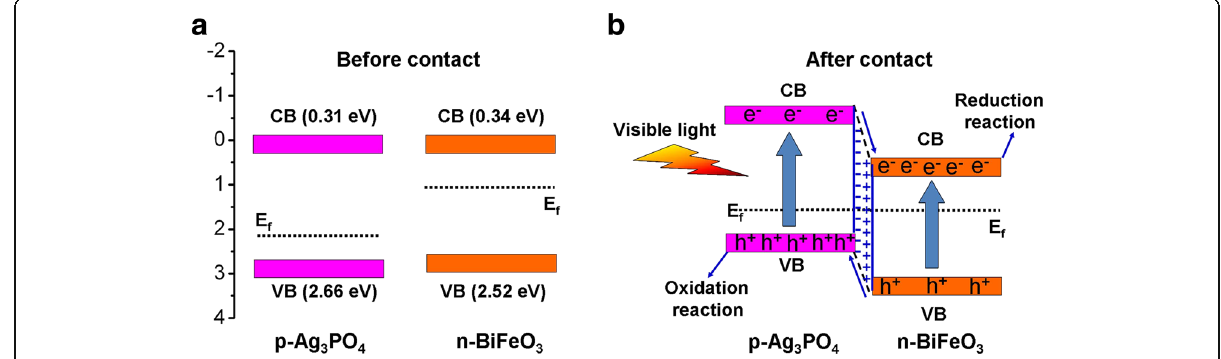
Fig. 12 Schematic illustration of proposed photocatalytic mechanism for Ag 3 PO 4 /BiFeO 3 composite. a Before contact. b After